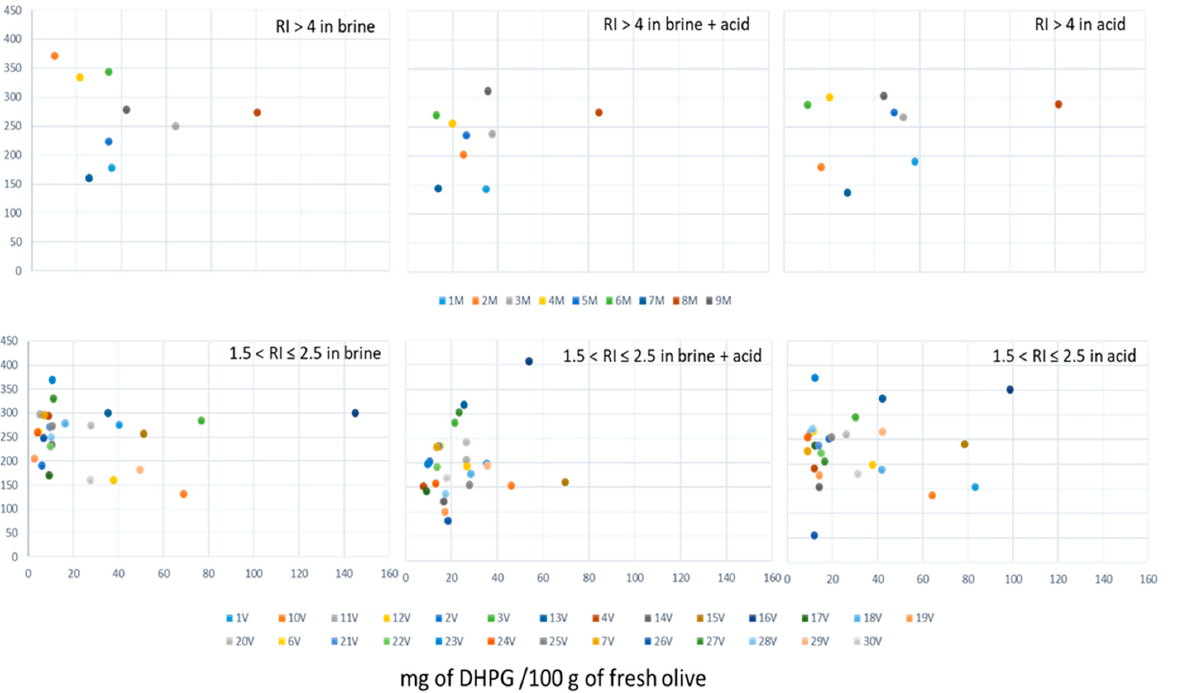
Figure 3. Maximum concentration of HT versus maximum concentration of DHPG achieved during the 12 months of storage for both ripeness stages of olives—higher than 4 (nine samples) and between 1.5 and 2.5 (thirty samples).